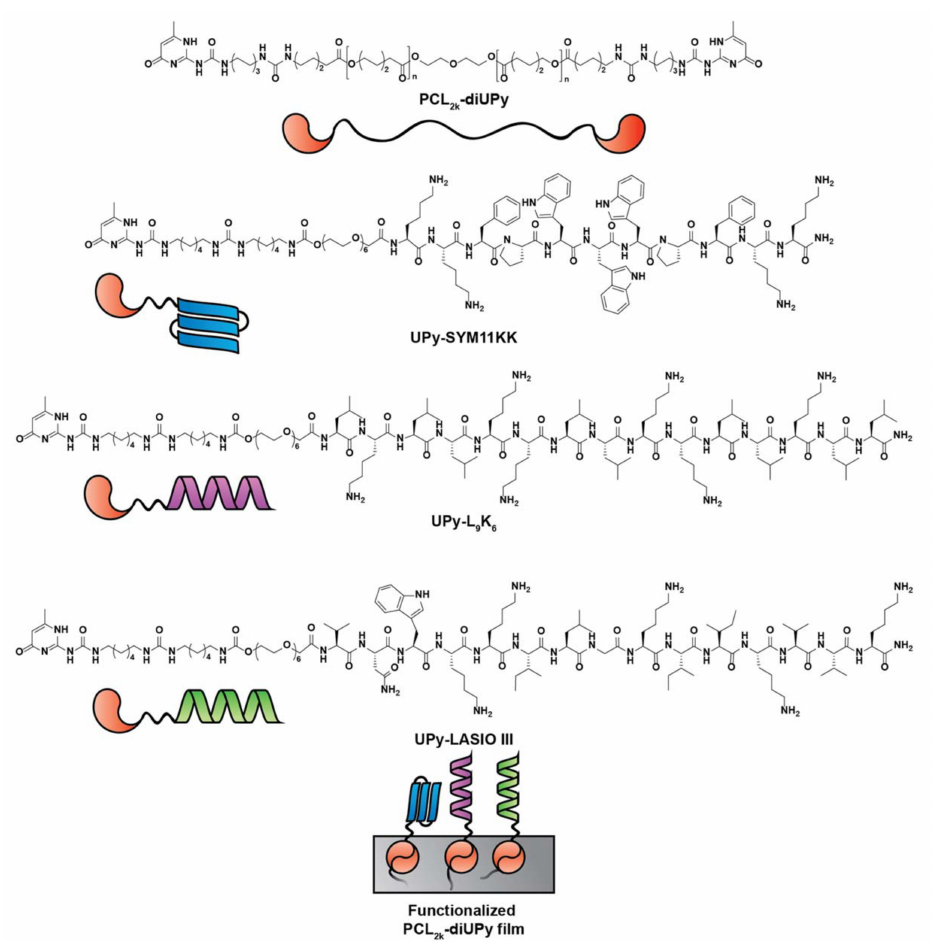
Figure 5. Schematic representations and molecular structures of the UPy-polymer and UPy-functionalized antimicrobial peptides SYM11KK, L9K6, and LASIO III to be applied as a supramolecular assembly-based strategy. Adapted with permission from reference